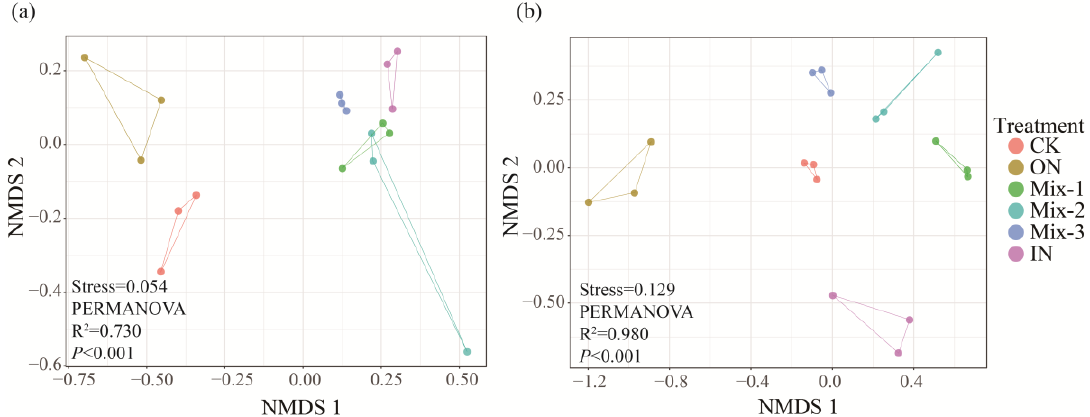
Figure 3. Nonmetric multidimensional scaling (NMDS) ordination plot based on the Bray – Curtis distance of samples for the bacterial ( a ) and fungal communities ( b ) in all treatments.